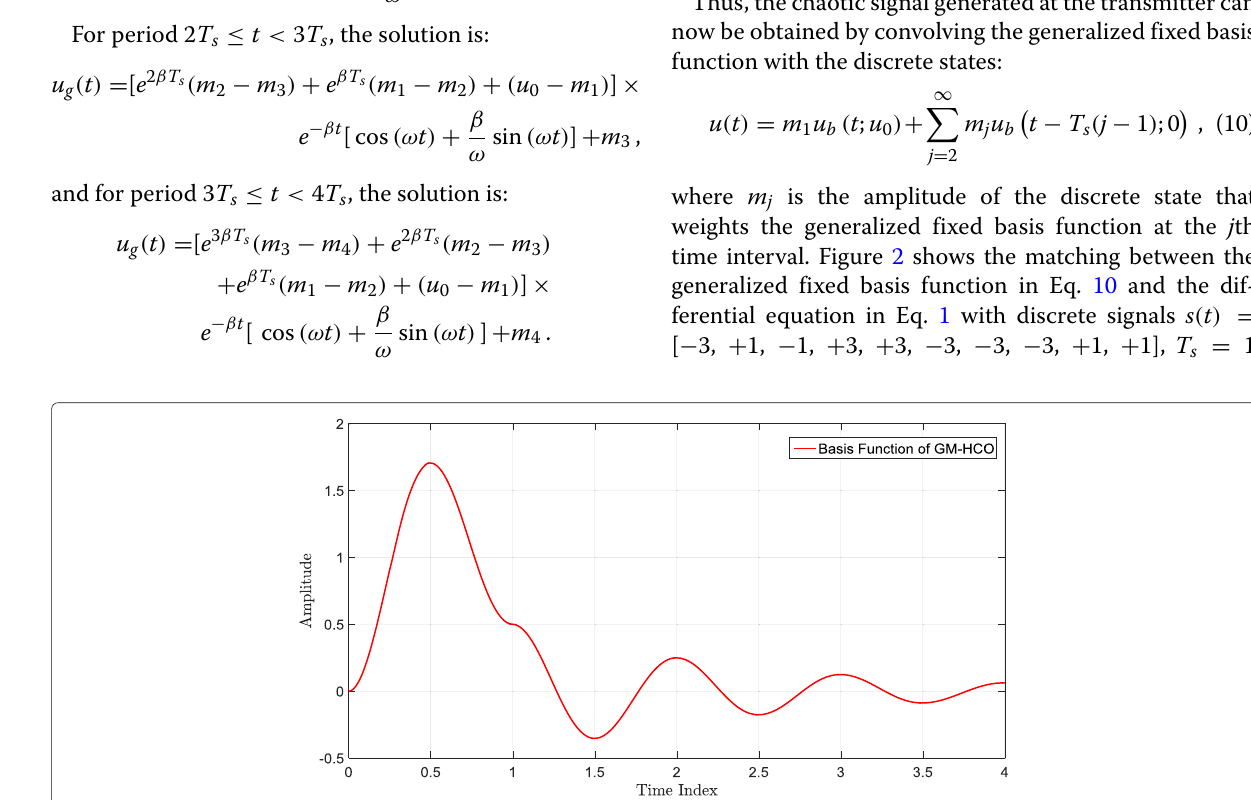
Fig. 1 Basis function, u b ( t ;0 ) , of